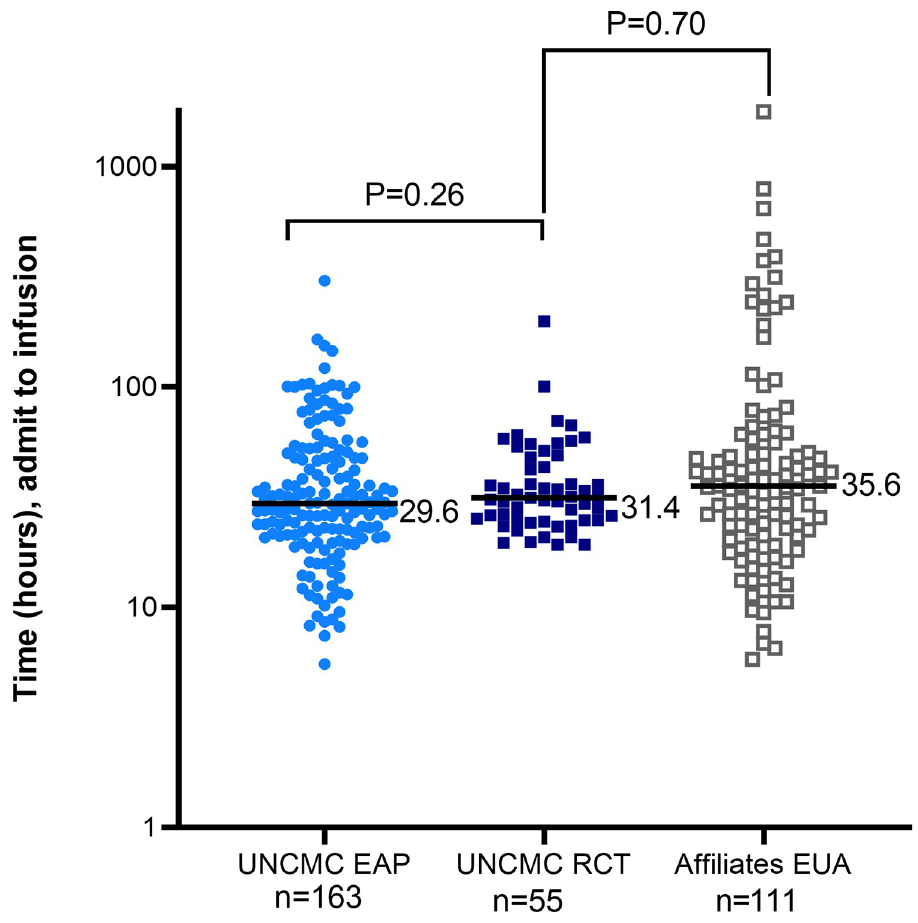
Fig 5. Time from admission to CCP infusion of EAP and RCT recipients at UNCMC and of EUA recipients at affiliates. UNCMC EAP reported in middle blue circles, UNCMC RCT reported in dark blue squares, Affiliates EUA reported in gray open squares. Medians are reported. P values obtained via a non-parametric Mann-Whitney U